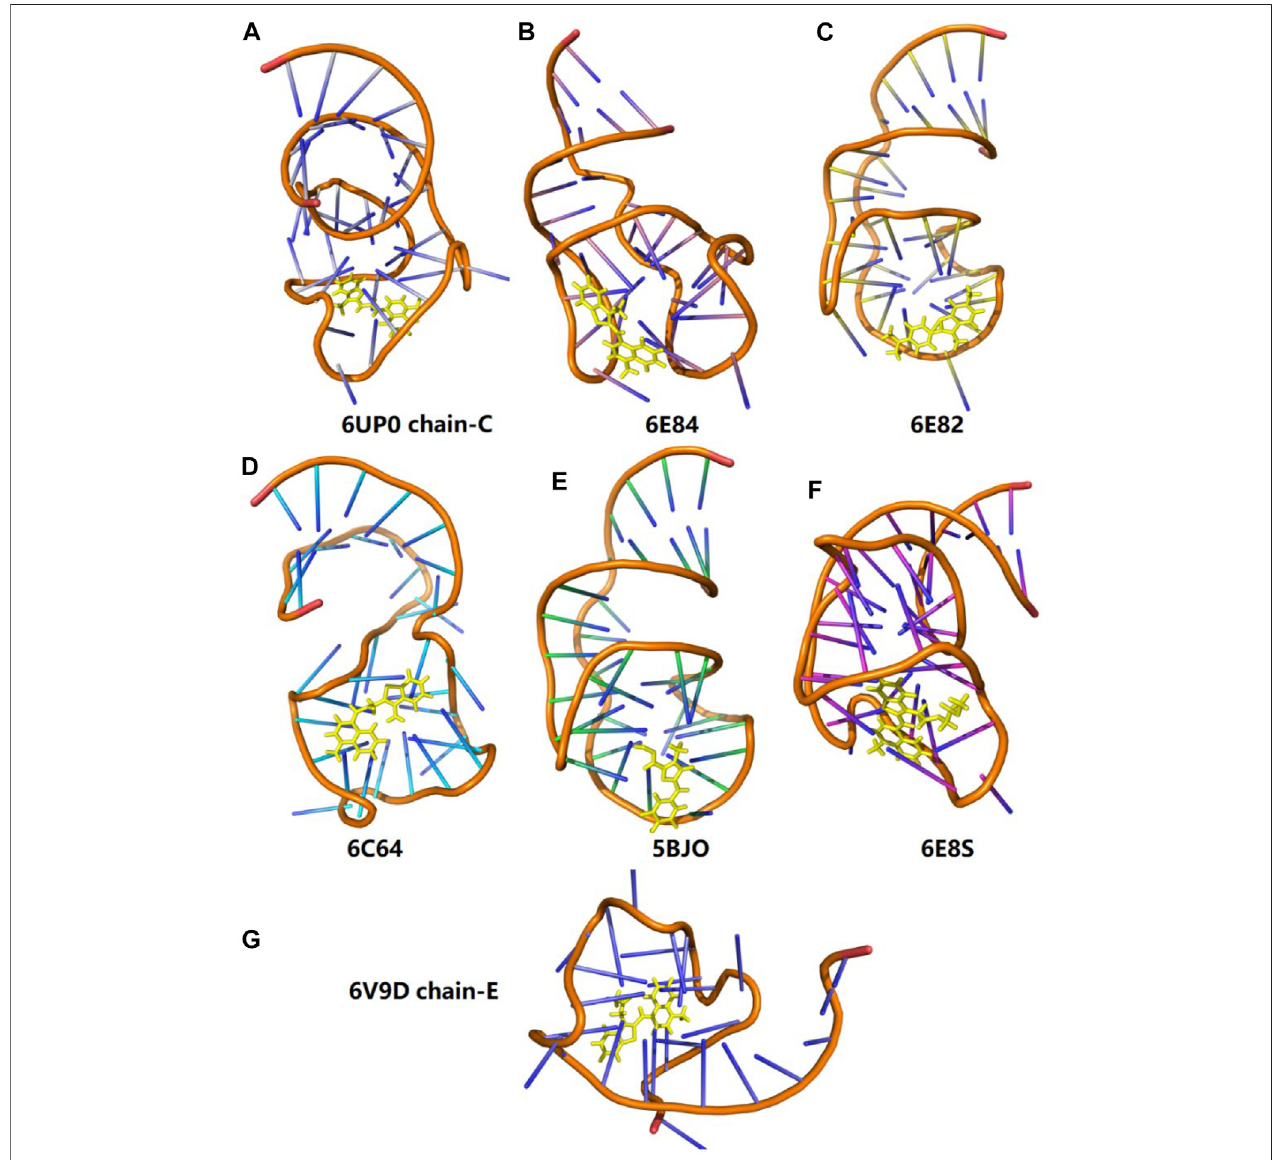
FIGURE 9 | Three-dimensional structures of seven different fl uorescent RNA – aptamer systems. The fl uorophore is shown in the yellow stick model.